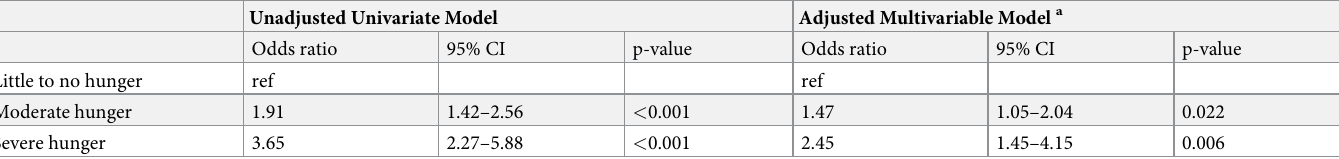
Table 2. Unadjusted univariate and adjusted multivariable associations between household food insecurity and history of severe, medically-attended cholera in a cross-sectional household survey of Mirebalais, Haiti 2019 (N = 1072). Unadjusted Univariate